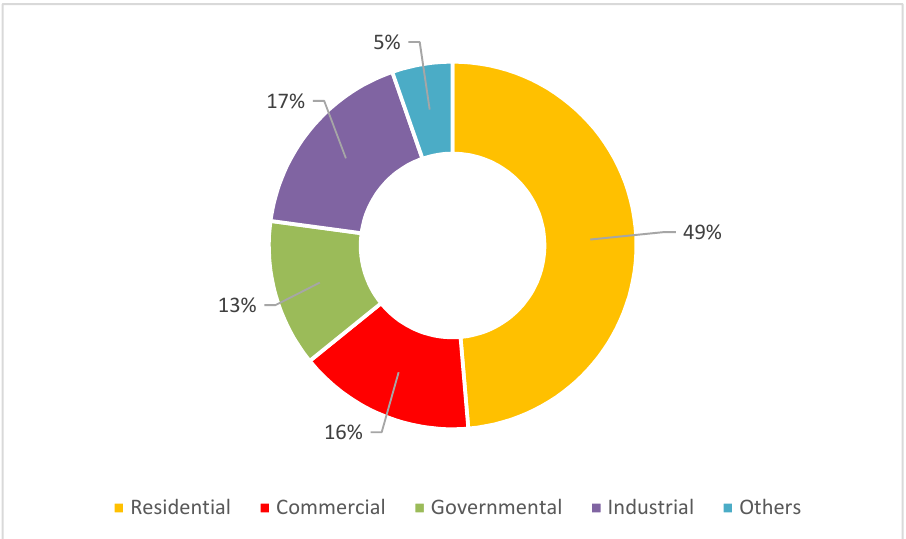
Figure 4. 2021 electricity consumption breakdown in Saudi Arabia [71].